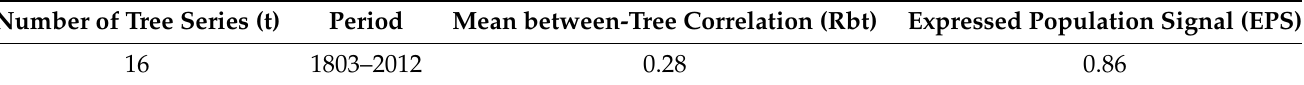
Figure 3. Tree ring series of each tree from Campos do Jordão (S i in mm, where i = 1,2, . . . ,16). Mean chronology (Mean in mm, the last panel). The 67% nsplines (two-third splines) with 50% of frequency cutoff were applied to remove the age trend (red lines). Table 1. Tree ring series